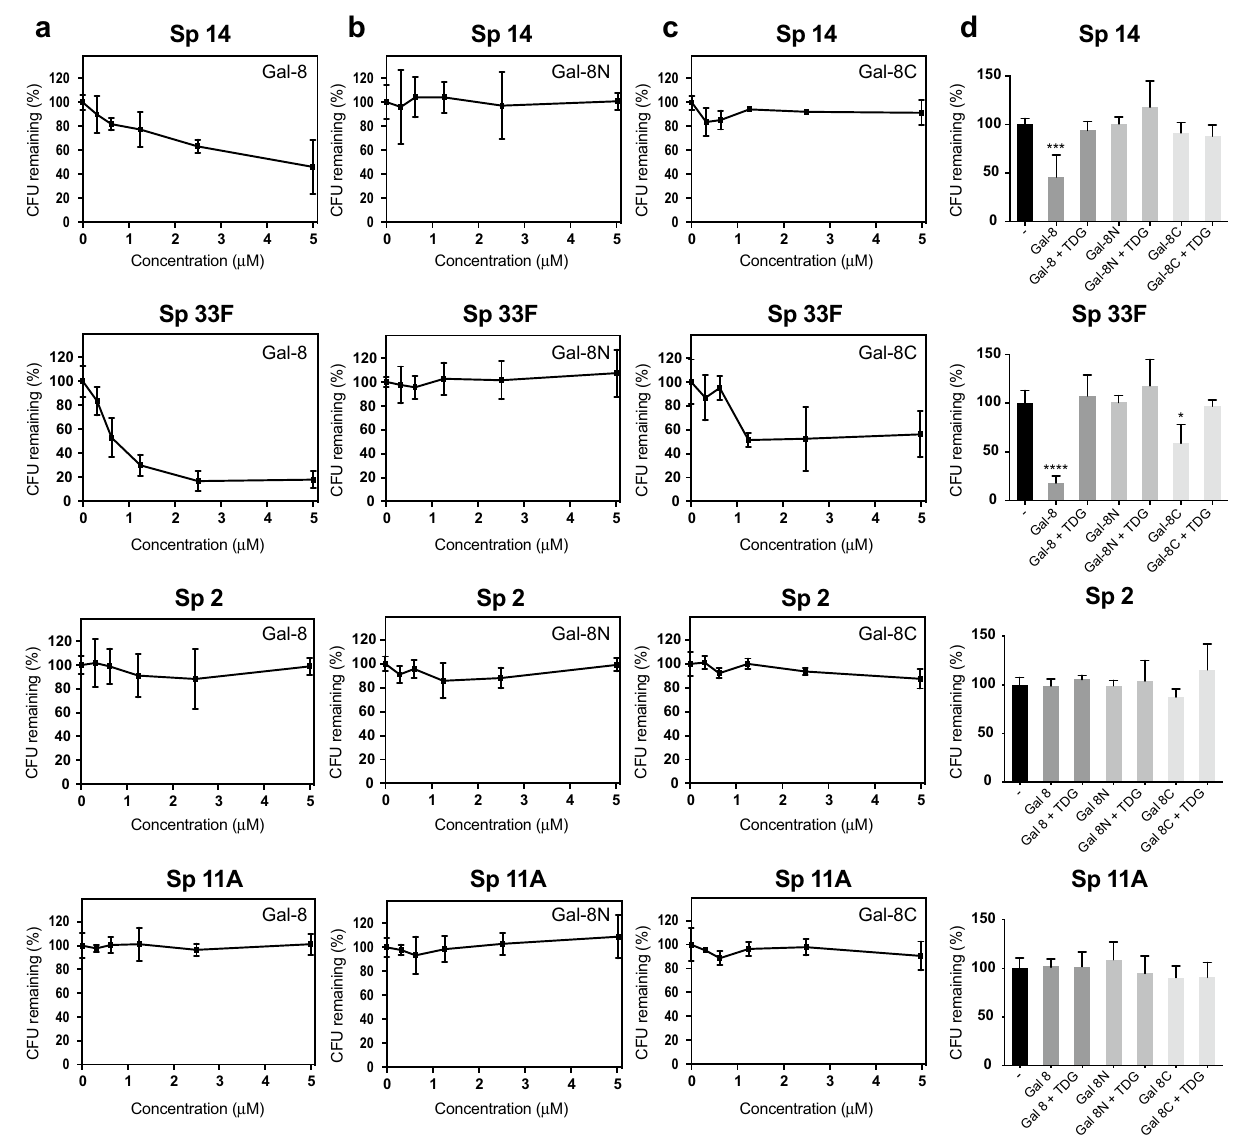
Figure 3. Measuring the impact of Gal-8 on the microbial viability ( a , b , and c ) Colony forming units (CFUs) remaining after incubation with the indicated concentrations of Gal-8 ( a ), Gal-8N ( b ), and Gal-8C ( c ). ( d ) Quantification of viable bacteria after incubation with PBS control, 5 μM Gal-8 or each of its domains with or without 50 mM TDG as indicated. Data are represented as mean values ± SD. Statistical analysis was performed using one-way ANOVA with Tukey’s test. P values less than 0.05, 0.001, and 0.0001 are summarized with one, three, and four asterisks,